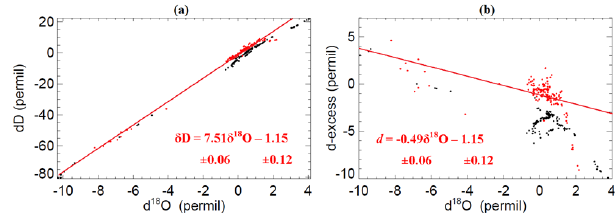
Fig. 8. (a) Observed (red) and modelled (black) relationship be- tween deuterium and oxygen-18 in sea surface waters. (b) Observed (red) and modelled (black) deuterium excess in sea surface waters. The regressions are calculated from measurements.